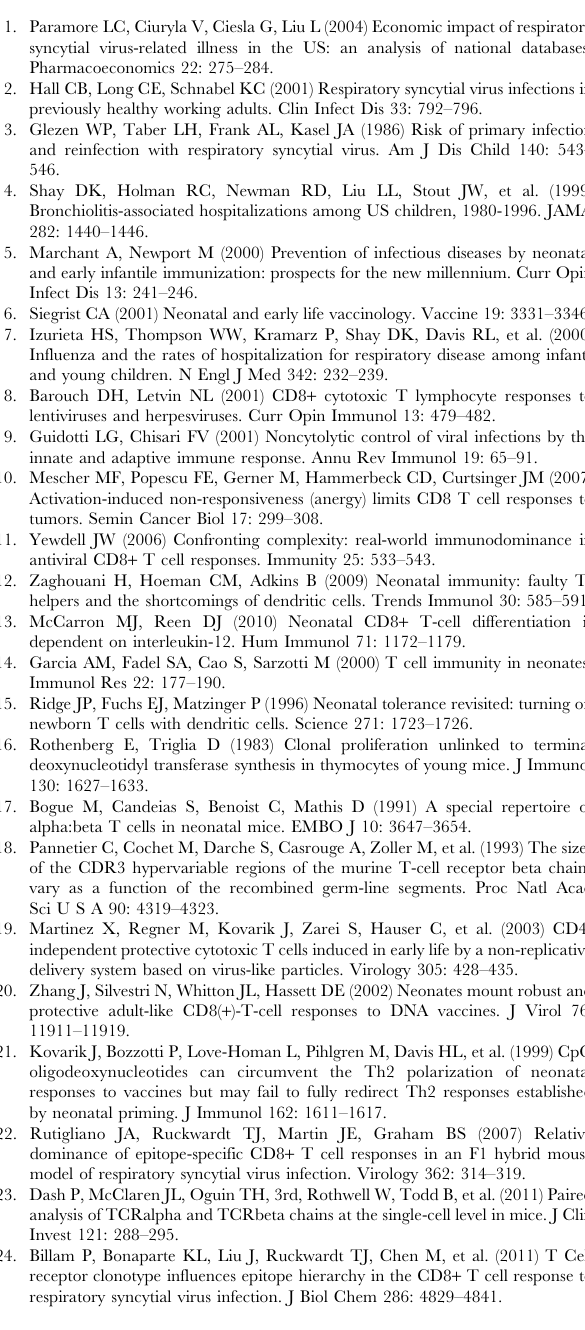
Figure S6 Schema for adoptive transfer of naı¨ve adult CD8 + T cells into congenic neonates prior to RSV infection and data